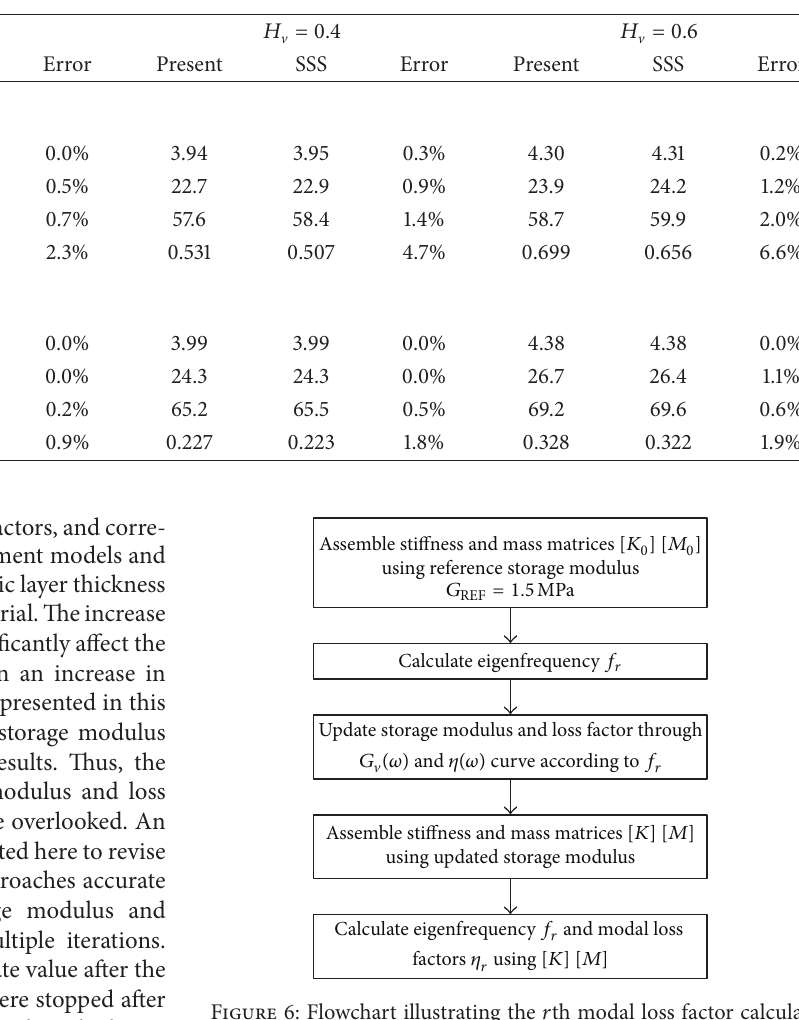
Table2:ComparisonbetweenpresentmodelandSSSmodelonfrequenciesandlossfactorsforvariousvaluesof 𝐻 V and 𝐺 V ( 𝐻 𝑏 = 𝐻 𝑐 = 0.001 , 𝑛 = 0 ).